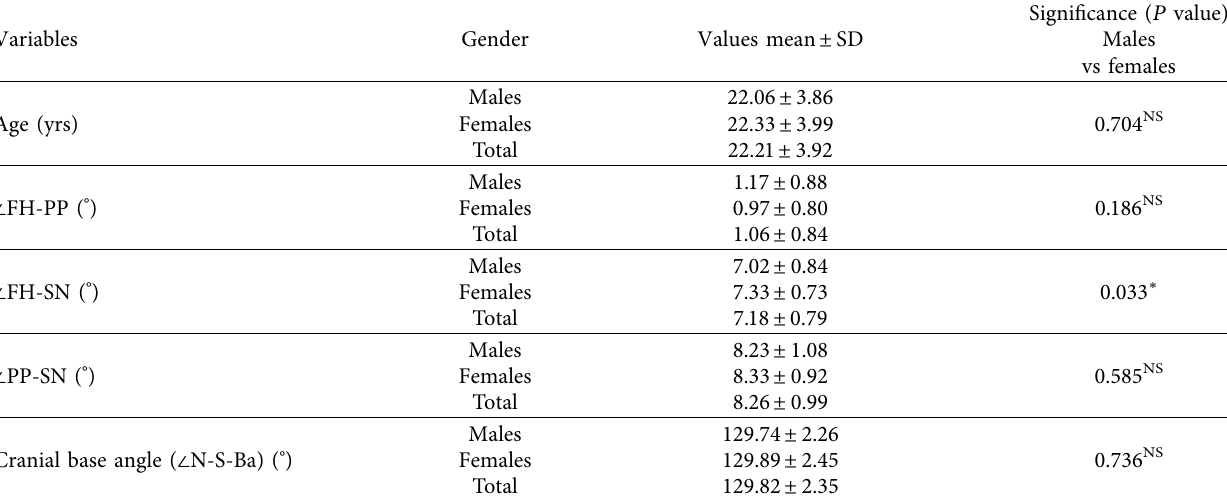
Table 1: Various descriptive parameters of the